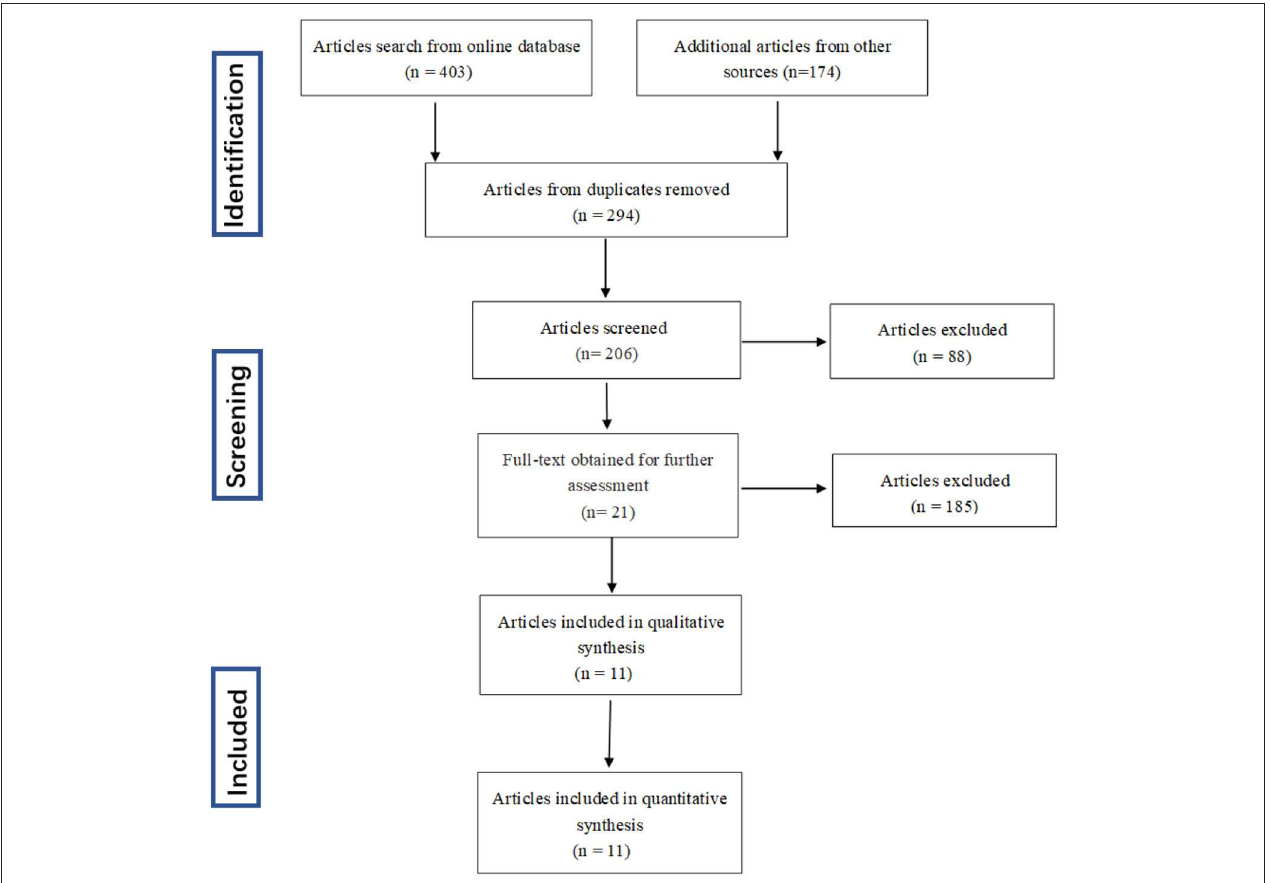
FIGURE 1 | Flow diagram of study selection